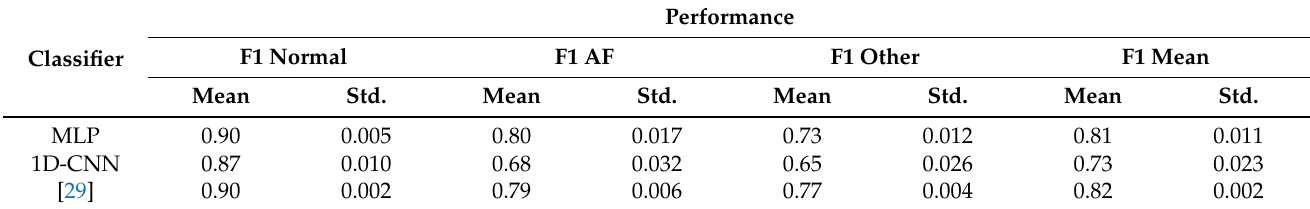
Table 3. Performance of the proposed methodology using 5-fold cross validation. Comparison with state-of-the-art.